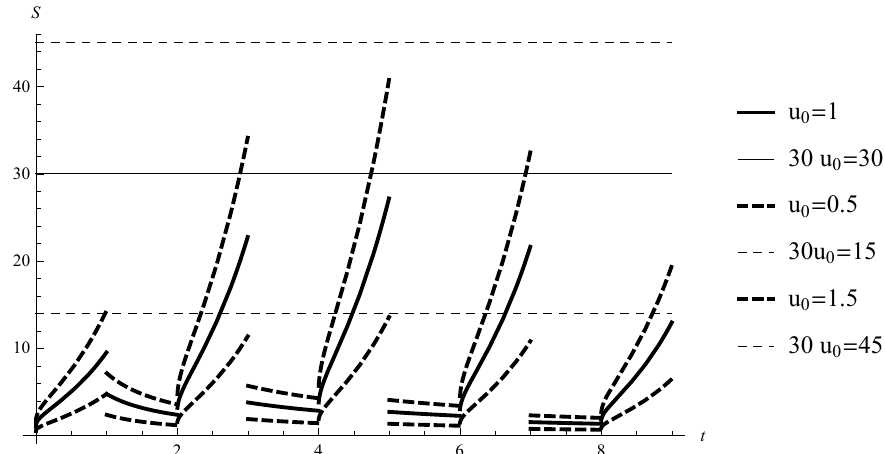
Figure 1. Example 2. Graph of the solution of Equation (11) with ψ k ( t , u ) = u